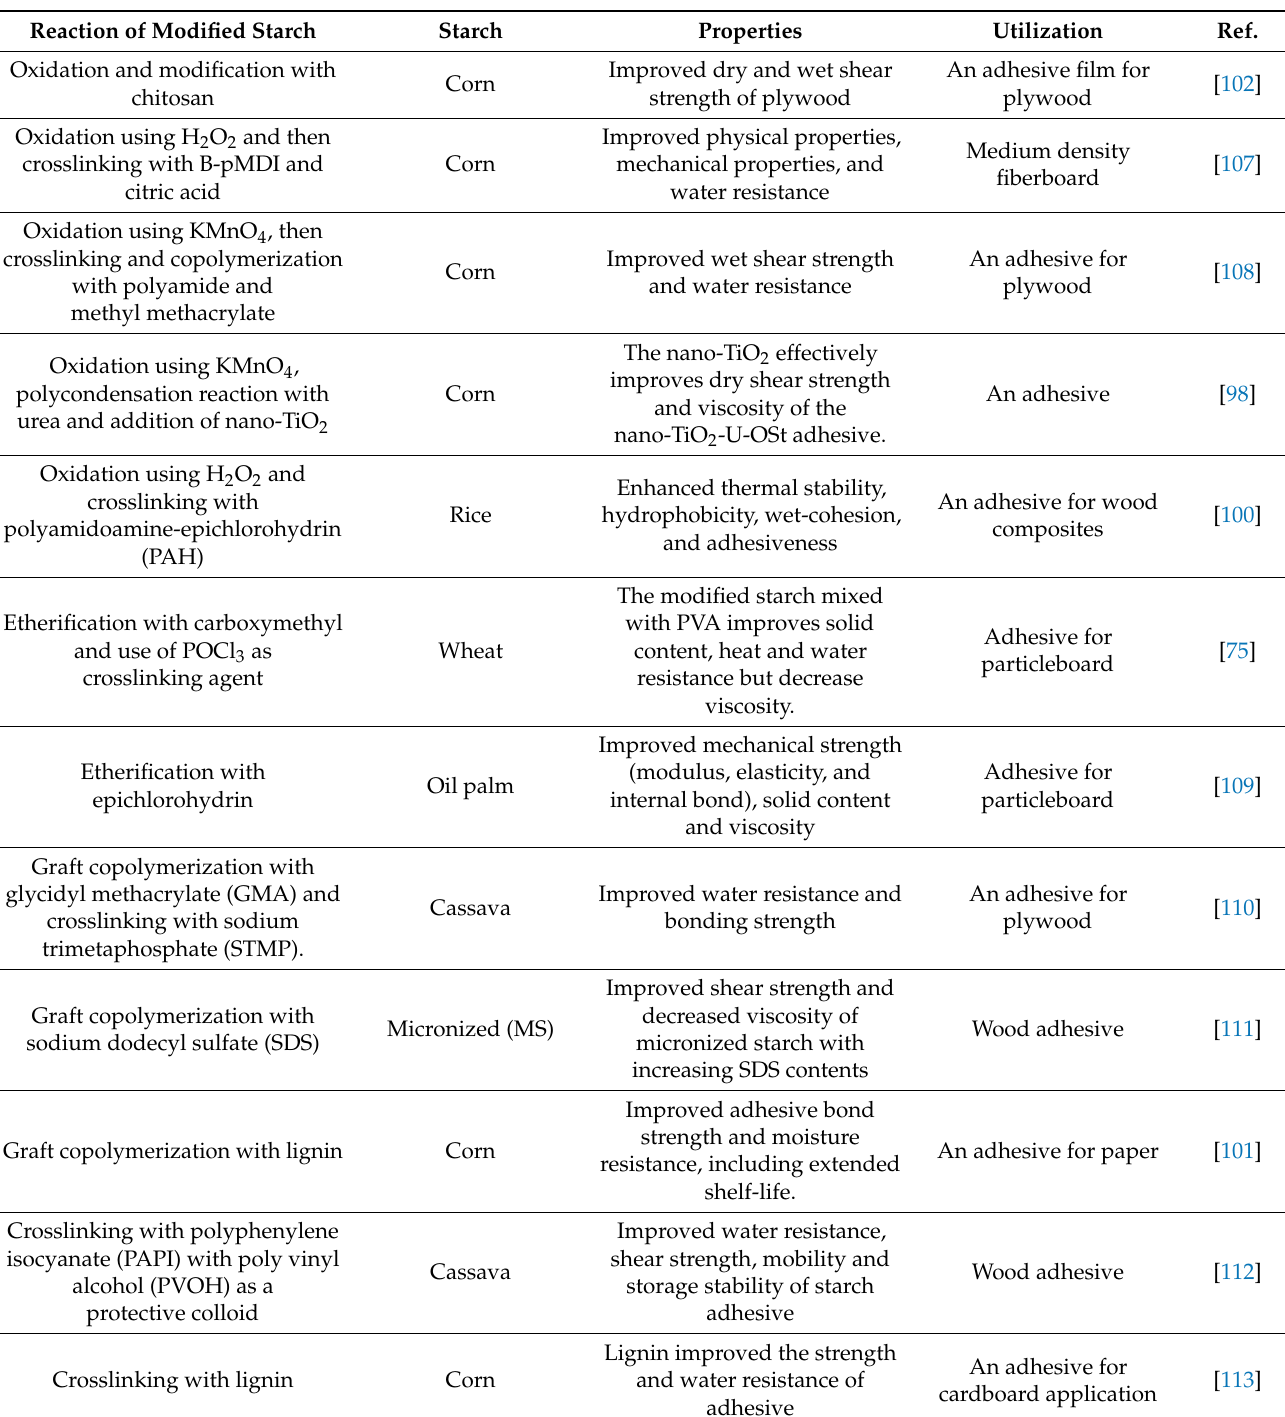
Table 4. The preparation of modified starch and adhesive application from different